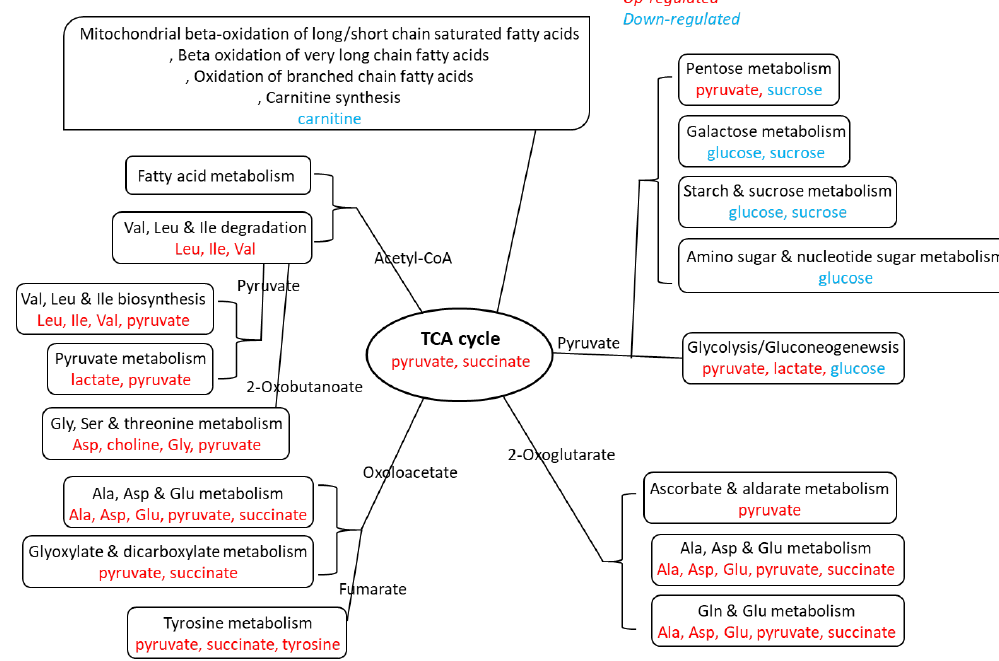
Figure 4. Metabolites in oral squamous cell carcinoma tumor. Upregulated (red) metabolites of pathways (black) involved in tumors irrespective of extranodal extension (ENE) status. Downregulated (blue) metabolites of pathways (black) involved in ENE(-) tumor but not ENE( + )